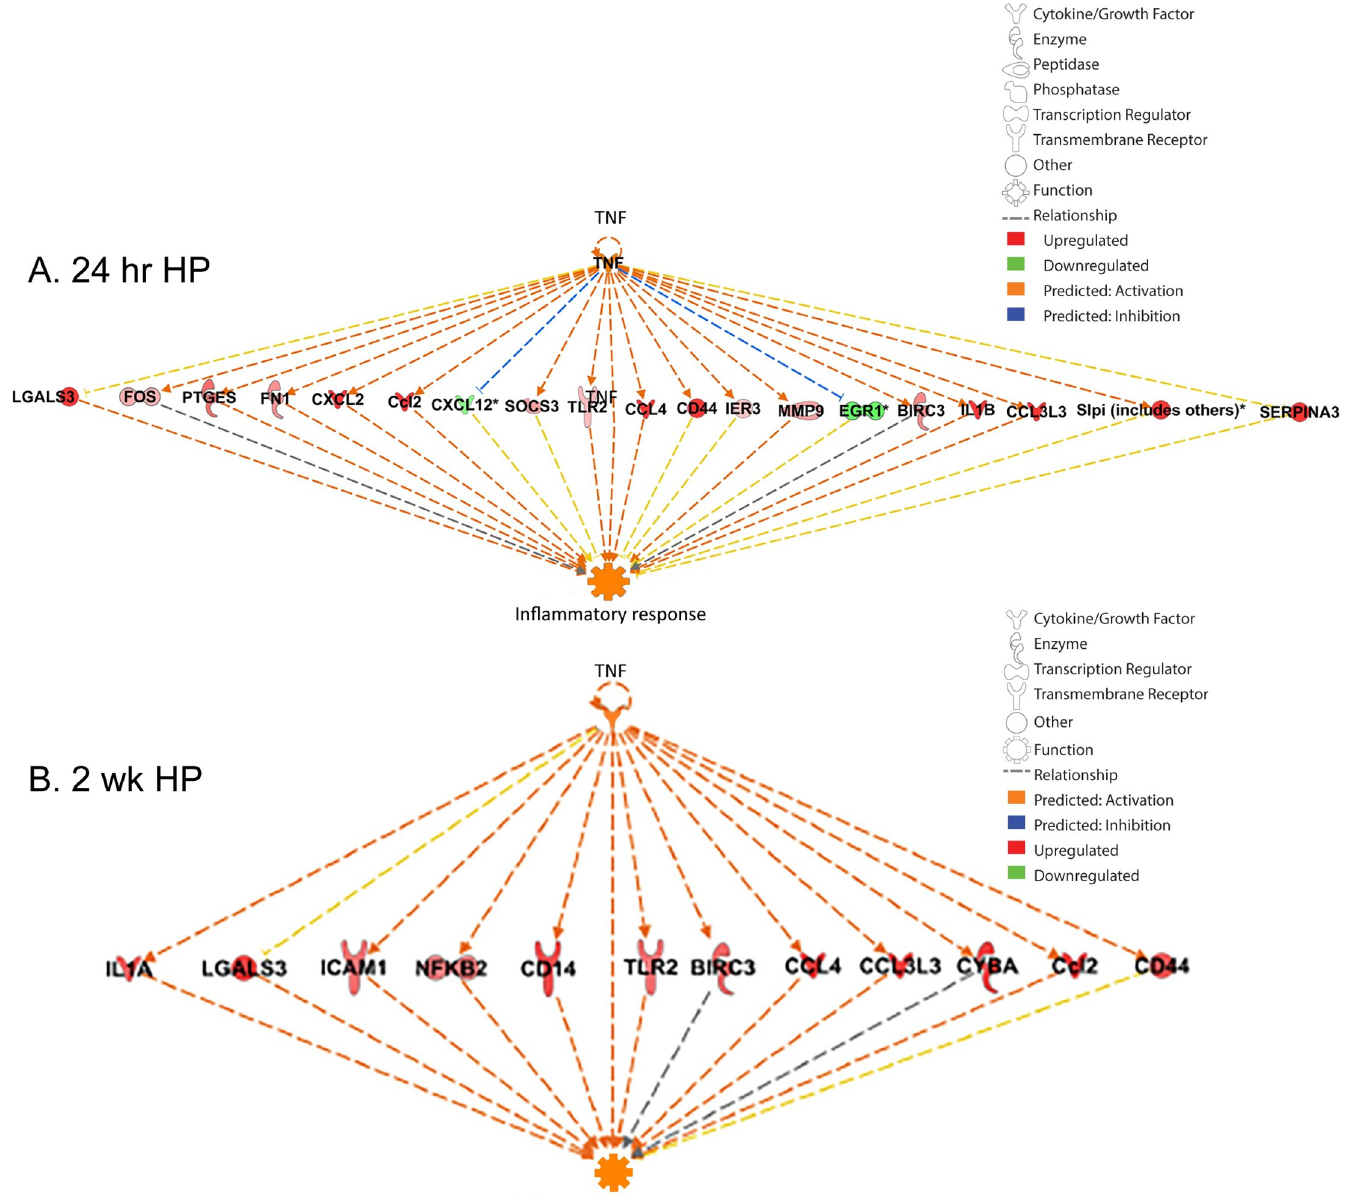
Fig 10. Upstream regulator analysis in ipa identifying tumor necrosis alpha (TNF- α ) as a major regulator of TBI-Dysregulated genes in the hippocampus. Upstream regulator analysis of hippocampal gene expression at 24 hr post-TBI (A). Upstream regulator analysis shows persistent dysregulation of genes predicted to be regulated by TNF- α 2 weeks post-injury in hippocampus